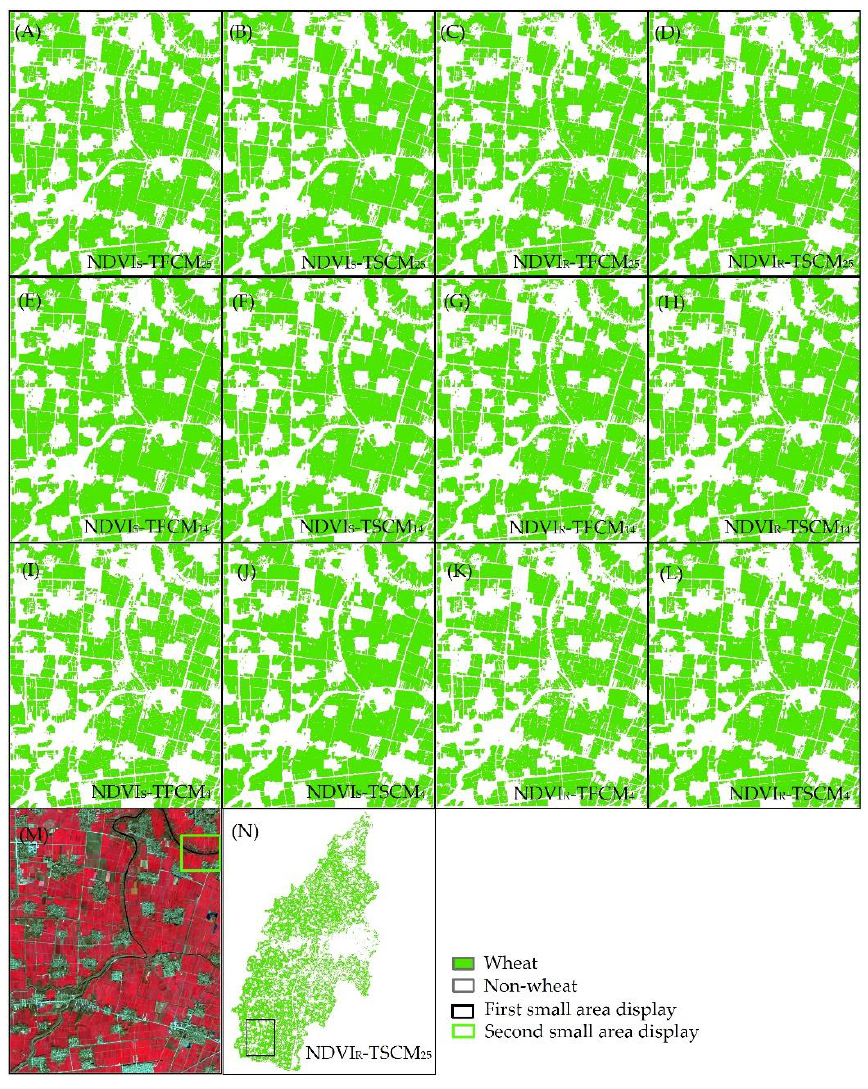
Figure 6. Comparison of crop classification accuracy between NDVI-TSCM and NDVI-TFCM over the first small region; the classification results of NDVI S -TFCM 25 ( A ), NDVI S -TSCM 25 ( B ), NDVI R -TFCM 25 ( C ), NDVI R -TSCM 25 ( D ), NDVI S -TFCM 14 ( E ), NDVI S -TSCM 14 ( F ), NDVI R -TFCM 14 ( G ), NDVI R -TSCM 14 ( H ), NDVI S -TFCM 4 ( I ), NDVI S -TSCM 4 ( J ), NDVI R -TFCM 4 ( K ), and NDVI R -TSCM 4 ( L ); a standard false color composite image using the ZY-3 data of 2 December 2014 ( M ); the classification result of the whole study area based on NDVIR-TSCM25 ( N ).